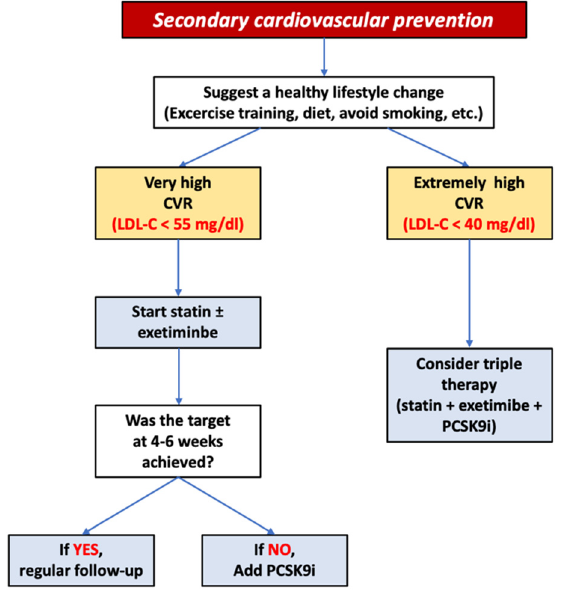
Figure 2. Flowchart of interventions for secondary cardiovascular prevention according to the European Society of Cardiology guidelines. CVR: cardiovascular risk, LDL-C: LDL cholesterol.